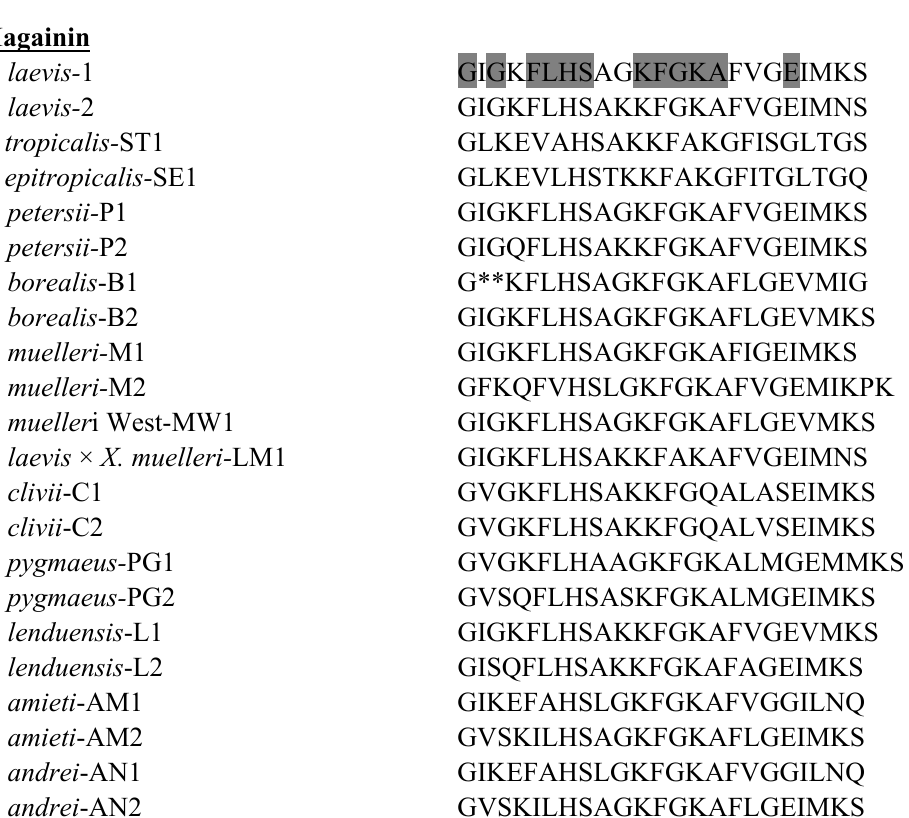
Figure 1. Primary structures of the magainin peptides isolated from skin secretions of frogs belonging to the genera Xenopus and Silurana . The amino acid sequence of magainin-ST1 was deduced from the corresponding nucleotide sequence of genomic DNA. In order to maximize structural similarity, gaps denoted by * have been introduced into some sequences. Strongly conserved residues are